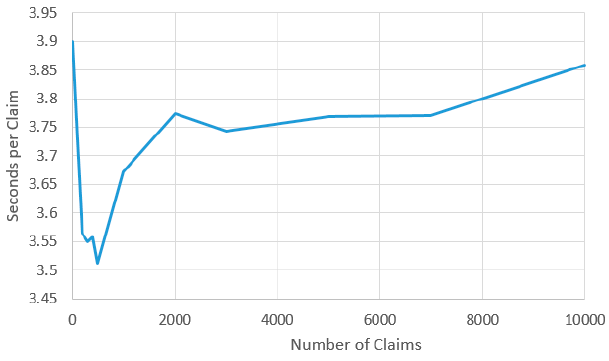
Figure 12. Average time needed to process a claim.